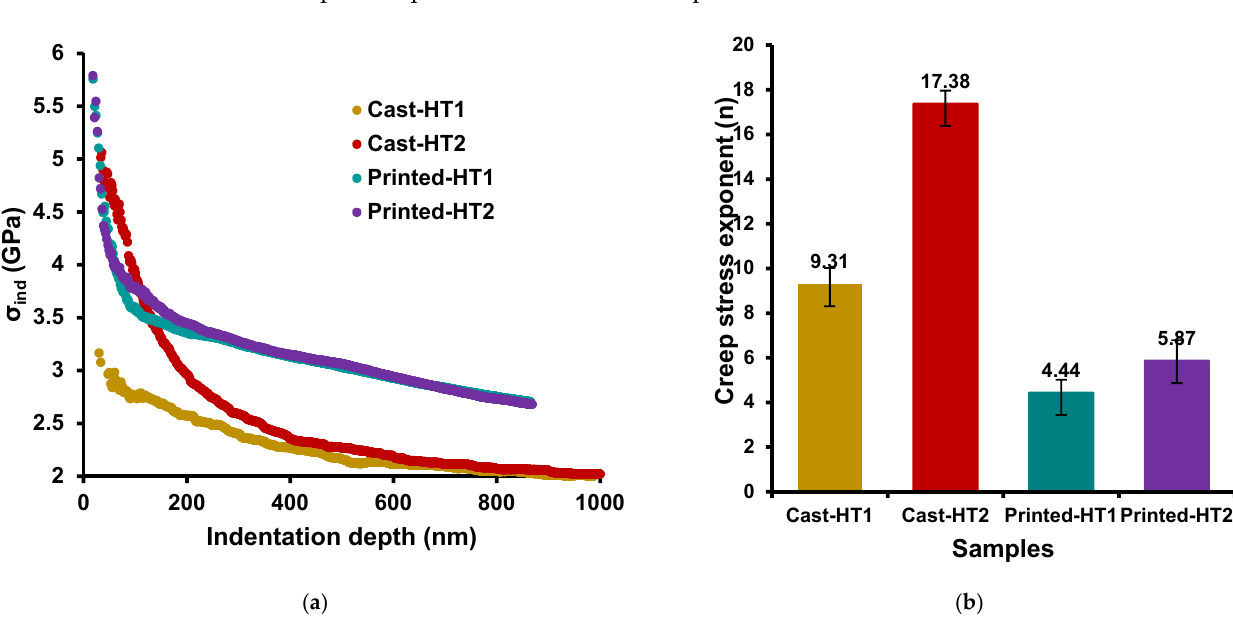
Figure 9. ( a ) Indentation size effect (ISE); ( b ) creep stress exponents (n) for two heat-treated samples in cast conditions and two heat-treated samples in the printed